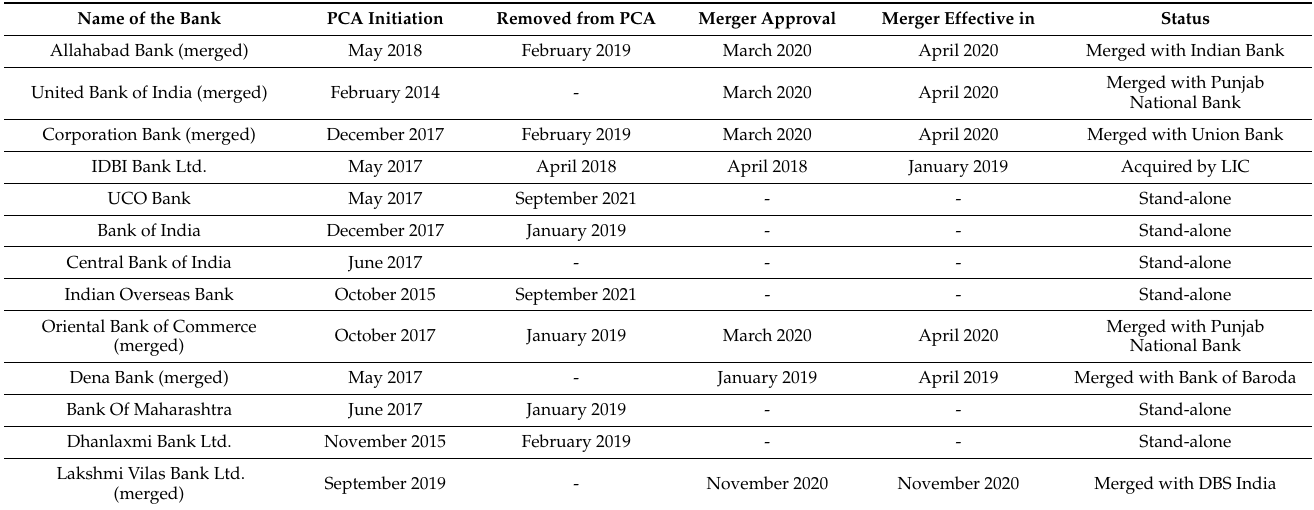
Table A4. List of Banks that came under RBI’s PCA and their status.